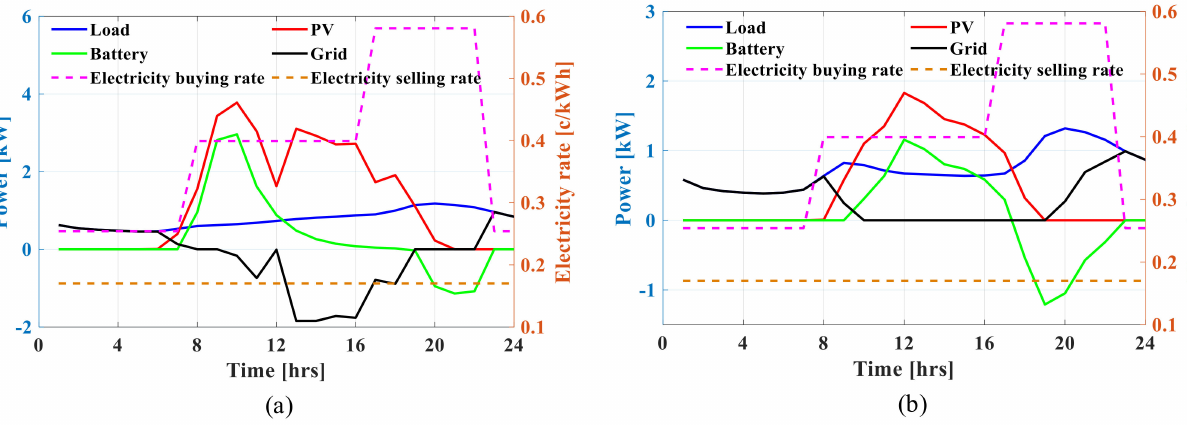
Figure 9. One day power flow and electricity rates under Flat-ToU rates: ( a ) Summer week, and ( b ) Winter